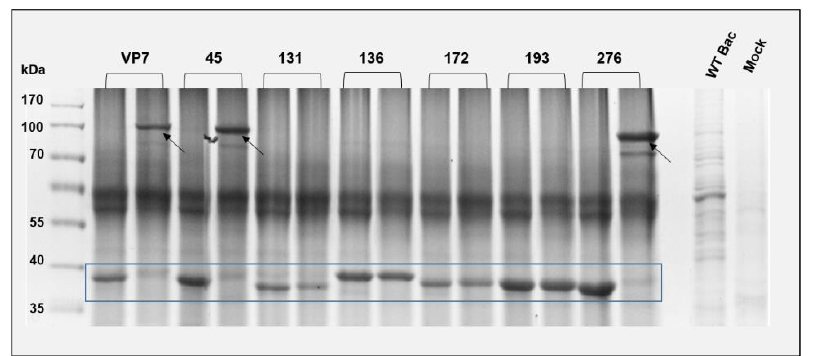
Figure 2. Trimerisation assay of modified VP7 proteins: A modified SDS-PAGE of heat-denatured ( left ) and non-denatured ( right ) samples from recombinant baculovirus-infected cell preparations of each mutant AHSV VP7 protein were run alongside one another. VP7 monomers are indicated by the ~38 kDa bands in the box. Multimers are indicated by high-molecular-weight bands (~100 kDa) in non-denatured samples comparable to WT VP7 (arrows). Wild-type baculovirus (WT Bac) and mock-infected cell preparations were used as controls.